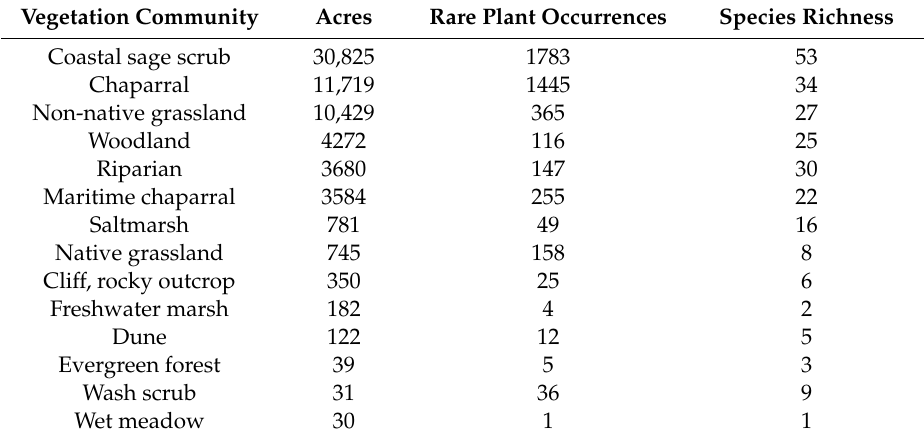
Table 4. Rare plant occurrences and rare plant species richness by acres of each vegetation community within the Natural Communities Coalition Reserve